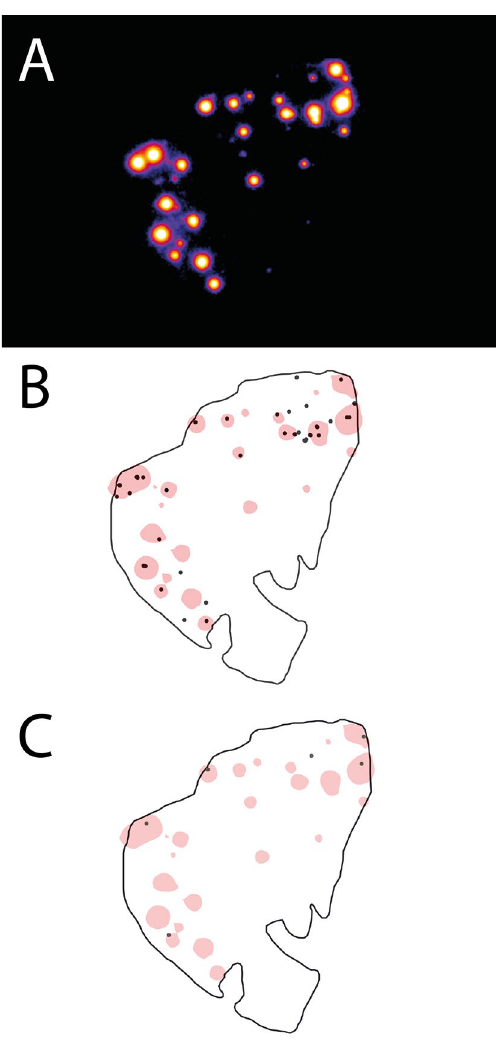
Figure 1. Autoradiography image of [ 18 F]-sodium fluoride ([ 18 F]-NaF) uptake ( A ), with the overlay image of [ 18 F]-NaF uptake with Alizarin red staining of microcalcifications ( B ) and Von Kossa staining of calcifications ( C